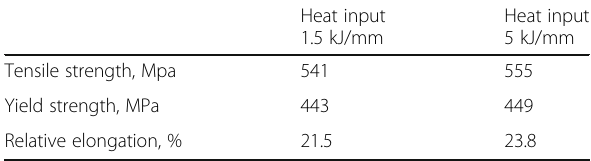
Table 7 Mechanical properties of welded joints of steel 09G2FB